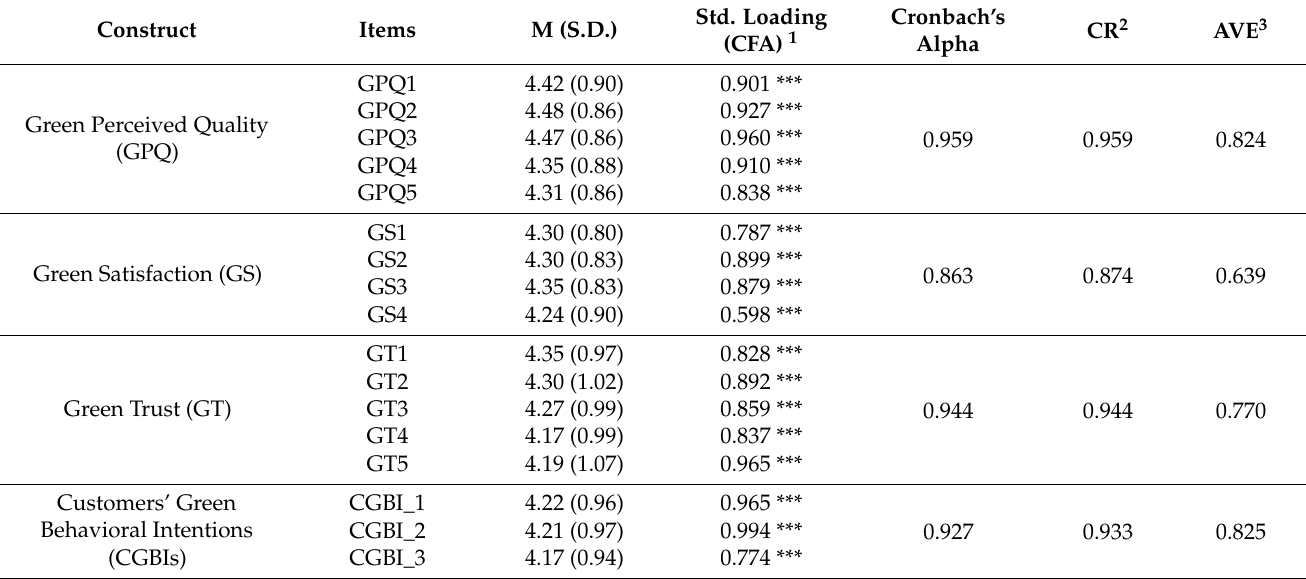
Table 2. Descriptive statistics, Reliability, and Confirmatory Factor Analysis